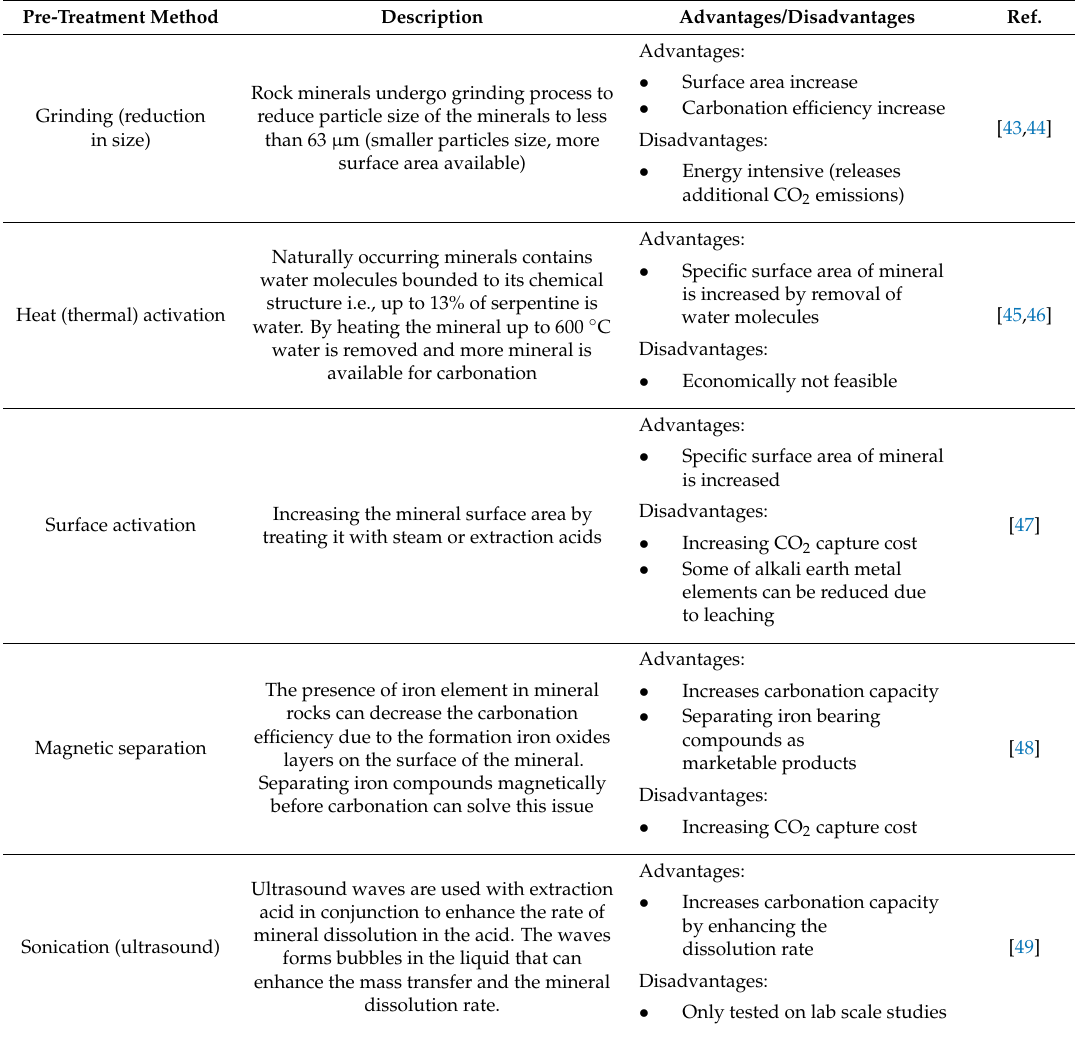
Table 4. Description of pretreatment